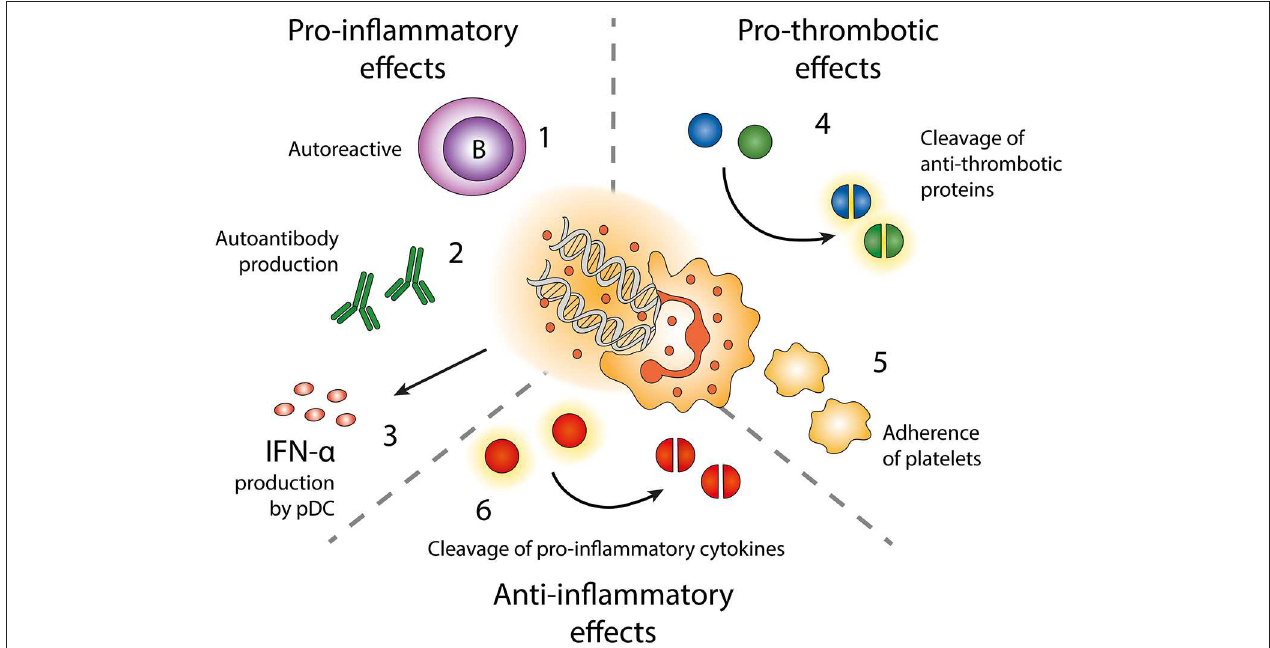
FIGURE 3 | Effects of neutrophil extracellular traps (NETs). Exposure of autoantigens leads to activation of autoreactive B-cells (1) and autoantibody production (2). NETs and NET-containing IC activate pDC to produce IFN- α (3). NETs contain enzymes cleaving anti-thrombotic proteins (4) resulting in activation of the coagulation cascade. NETs also form a scaffold onto which platelets can adhere and form thrombi (5). NET-related enzymes can also cleave and inactivate pro-inflammatory cytokines